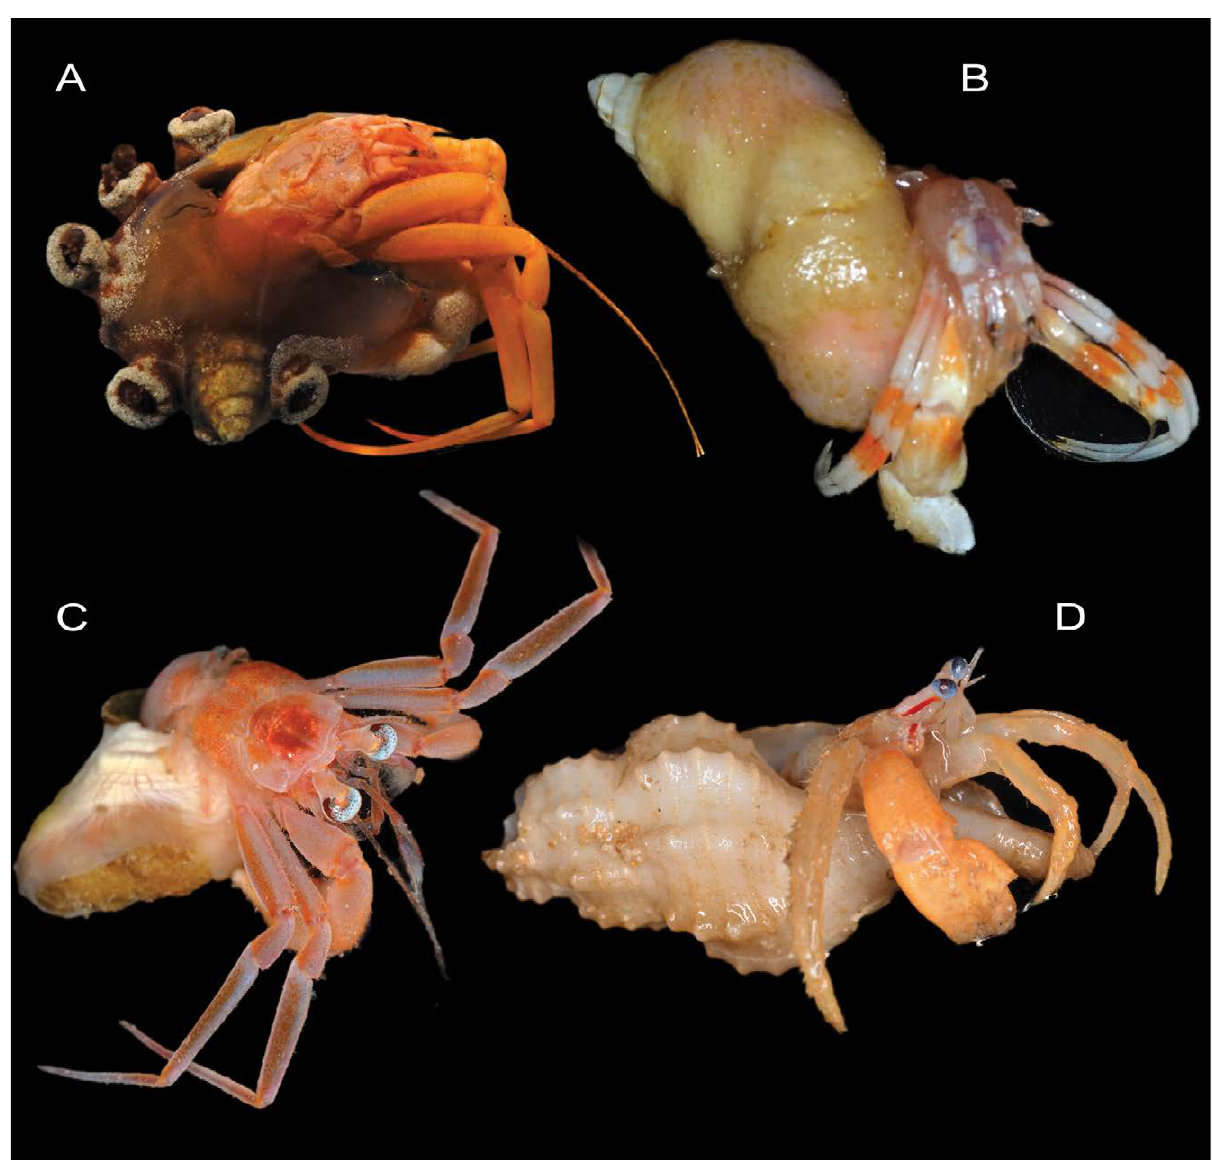
Fig. 21. – Colour photographs of species belonging to the family Parapaguridae. A, Parapagurus pilosimanus (IEOCD-BR/3195); B, Oncopagurus bicristatus (INFUECO1112); C, Strobopagurus gracilipes (IEOCD-BR/3193); D, Paragiopagurus ruticheles (IEOCD-